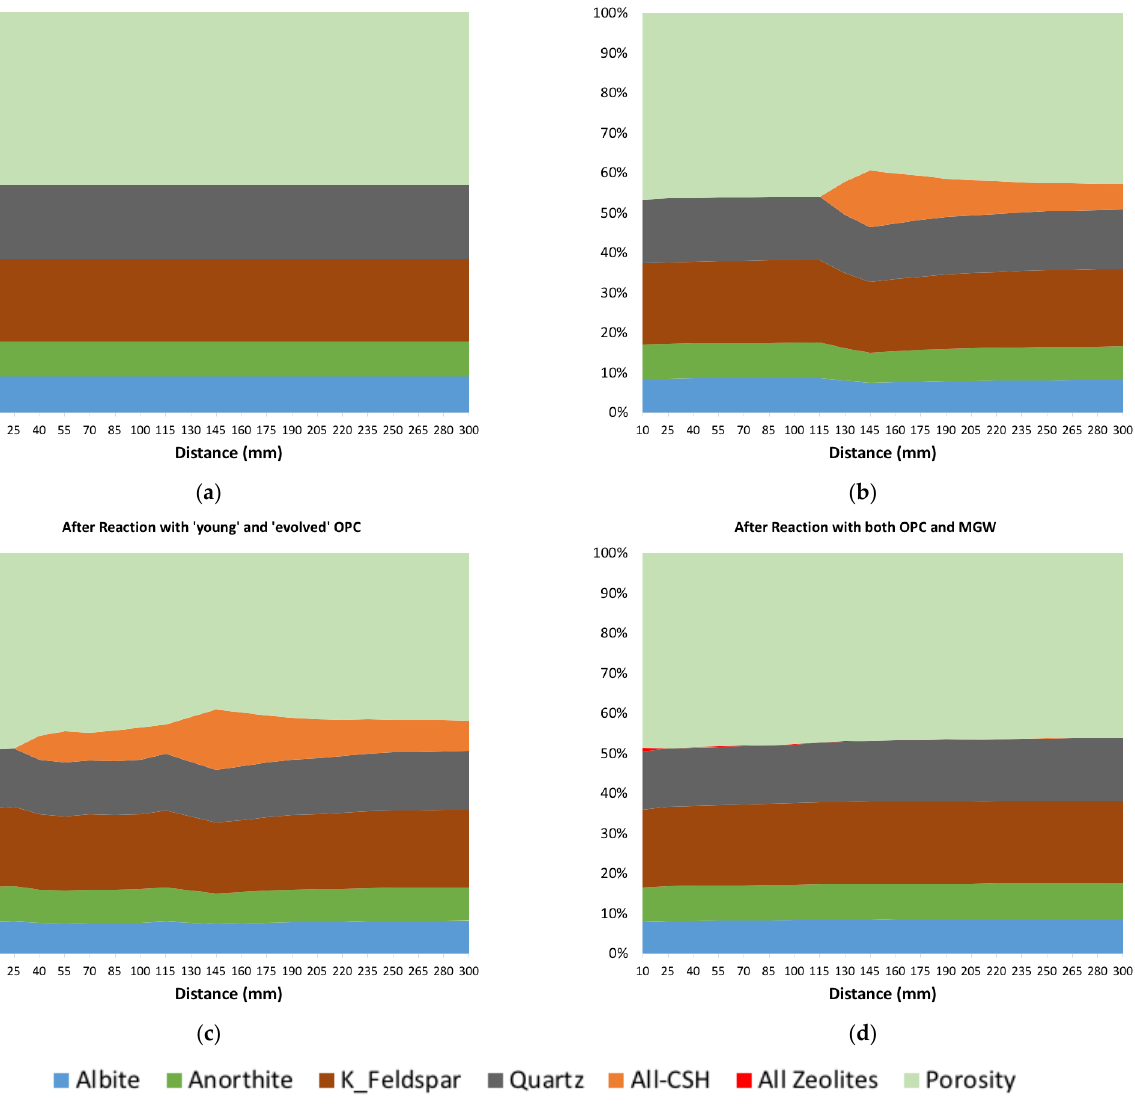
Figure 12. Legend for all plots. Summary of the composition of modelled mineral assemblage: ( a ) Toki granite before reaction, ( b ) after reaction with ‘young’ OPC leachate for ~100 d, ( c ) after successive reaction with both OPC leachates (~200 d), and ( d ) after successive reaction with both OPC leachates and MGW (~255 d).